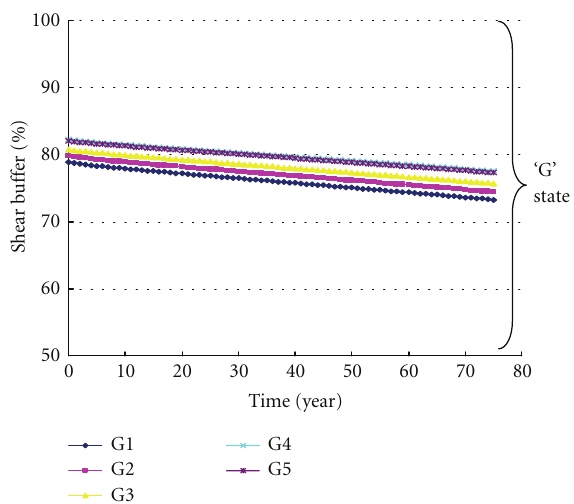
Figure 7: Shear bu ff er over life span of carbon steel girders.